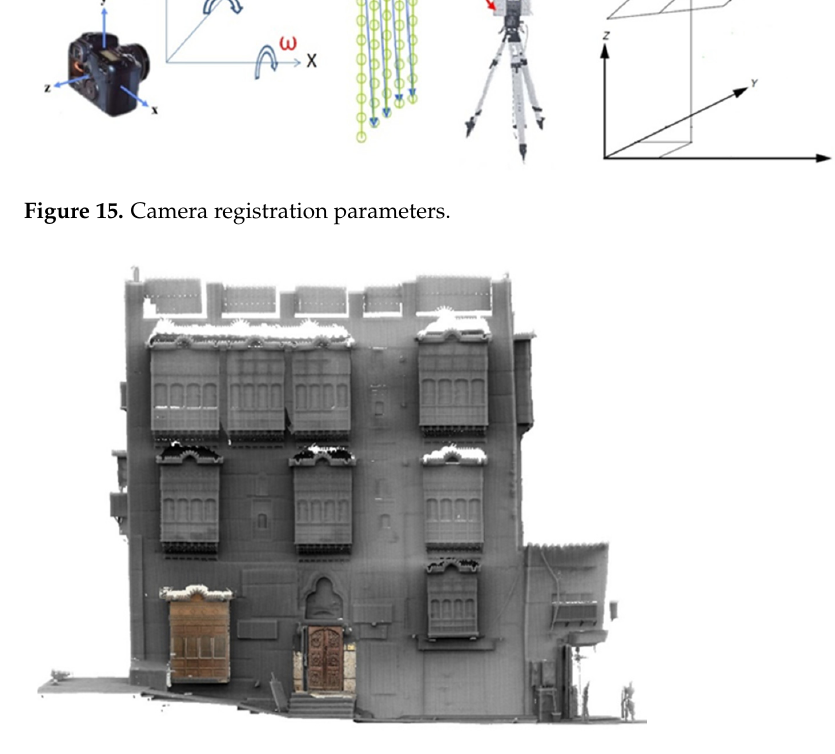
Figure 16. Data fusion of 3D image-based points cloud (Roshan and the main door) with the TLS point cloud (shaded).